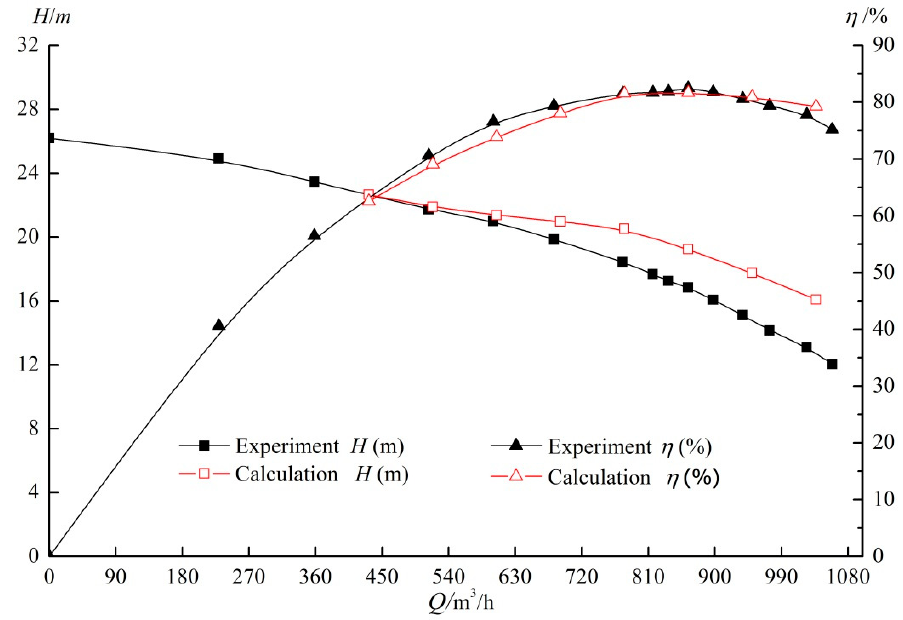
Figure 5. Comparison of pump performance between experiment and calculation results.